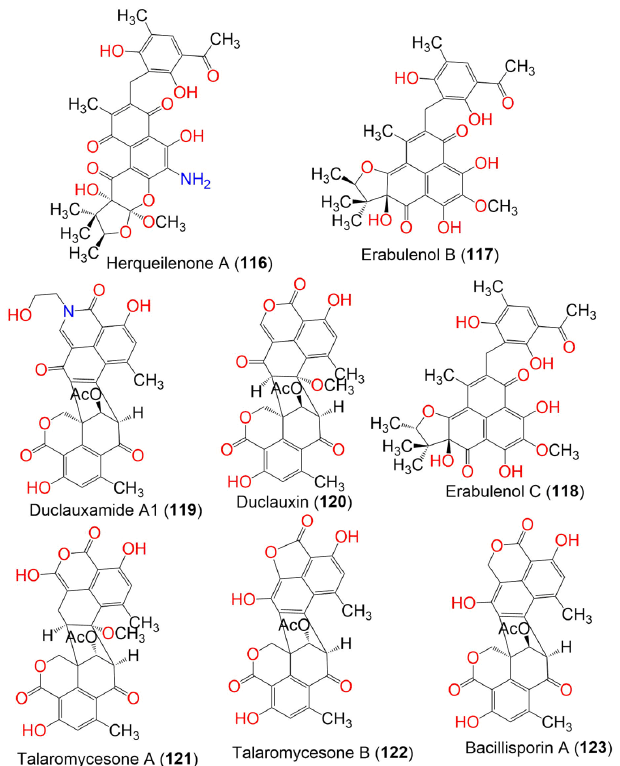
Figure 12. Structures of compounds 116 – 123 .